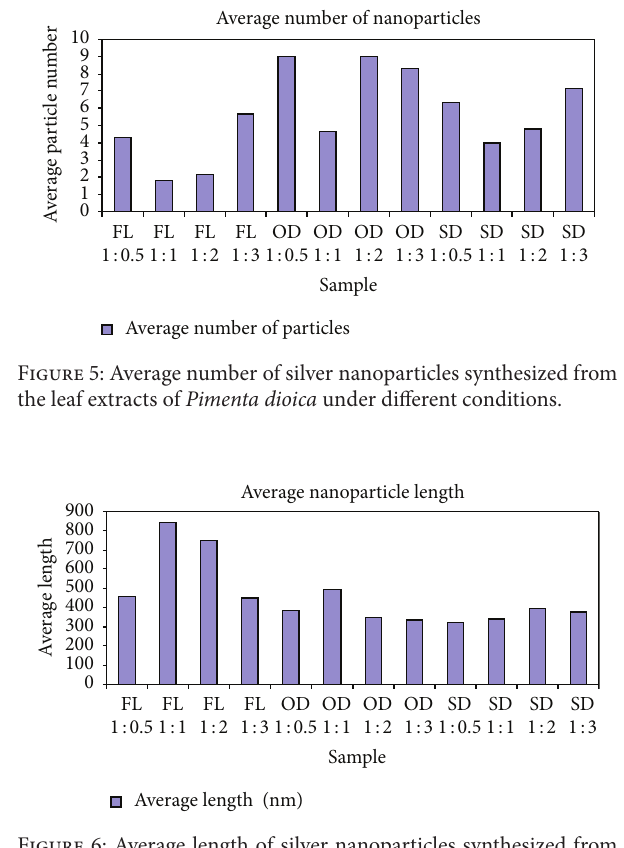
Figure 6: Average length of silver nanoparticles synthesized from the leaf extracts of Pimenta dioica under different conditions.